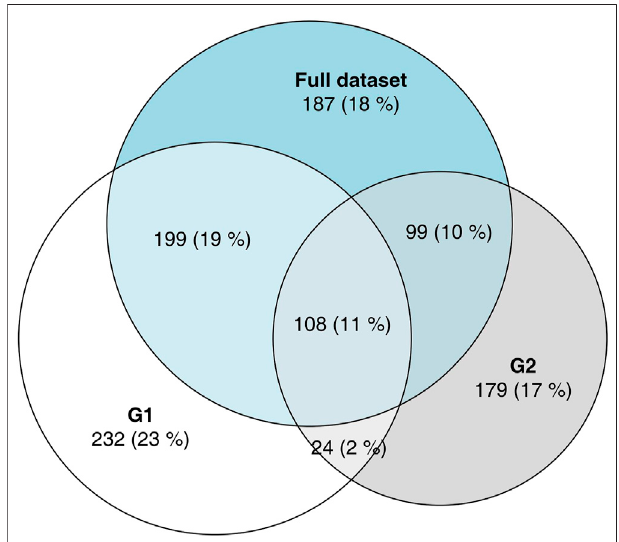
FIGURE 3 | Area-proportional Venn diagram showing overlaps in DEGs between G1, G2 and the full data set. The majority of genes which have been labeled as DEGs in only one of the groups G1, G2 are DEGs when all data were